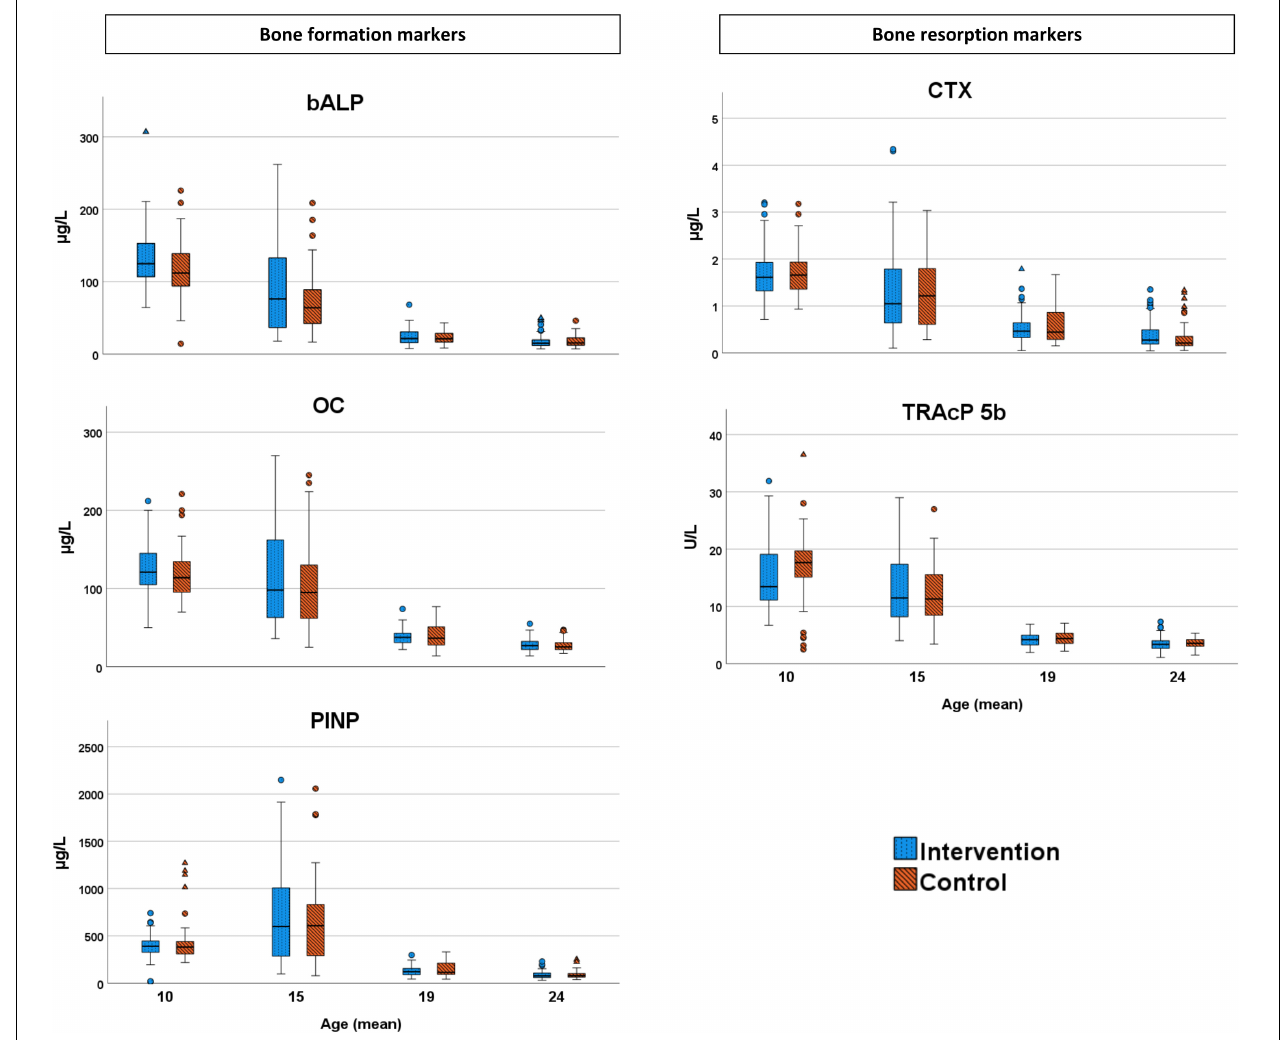
FIGURE 2 | Bone formation markers [bone-specific alkaline phosphatase (bALP), osteocalcin (OC), and N-terminal propeptide of collagen type 1 (PINP)] and bone resorption markers [C-terminal telopeptide cross links (CTX) and tartrate-resistant acid phosphatase (TRAcP 5b)] in the intervention and control group. Outliers are marked as circles and extreme outliers as